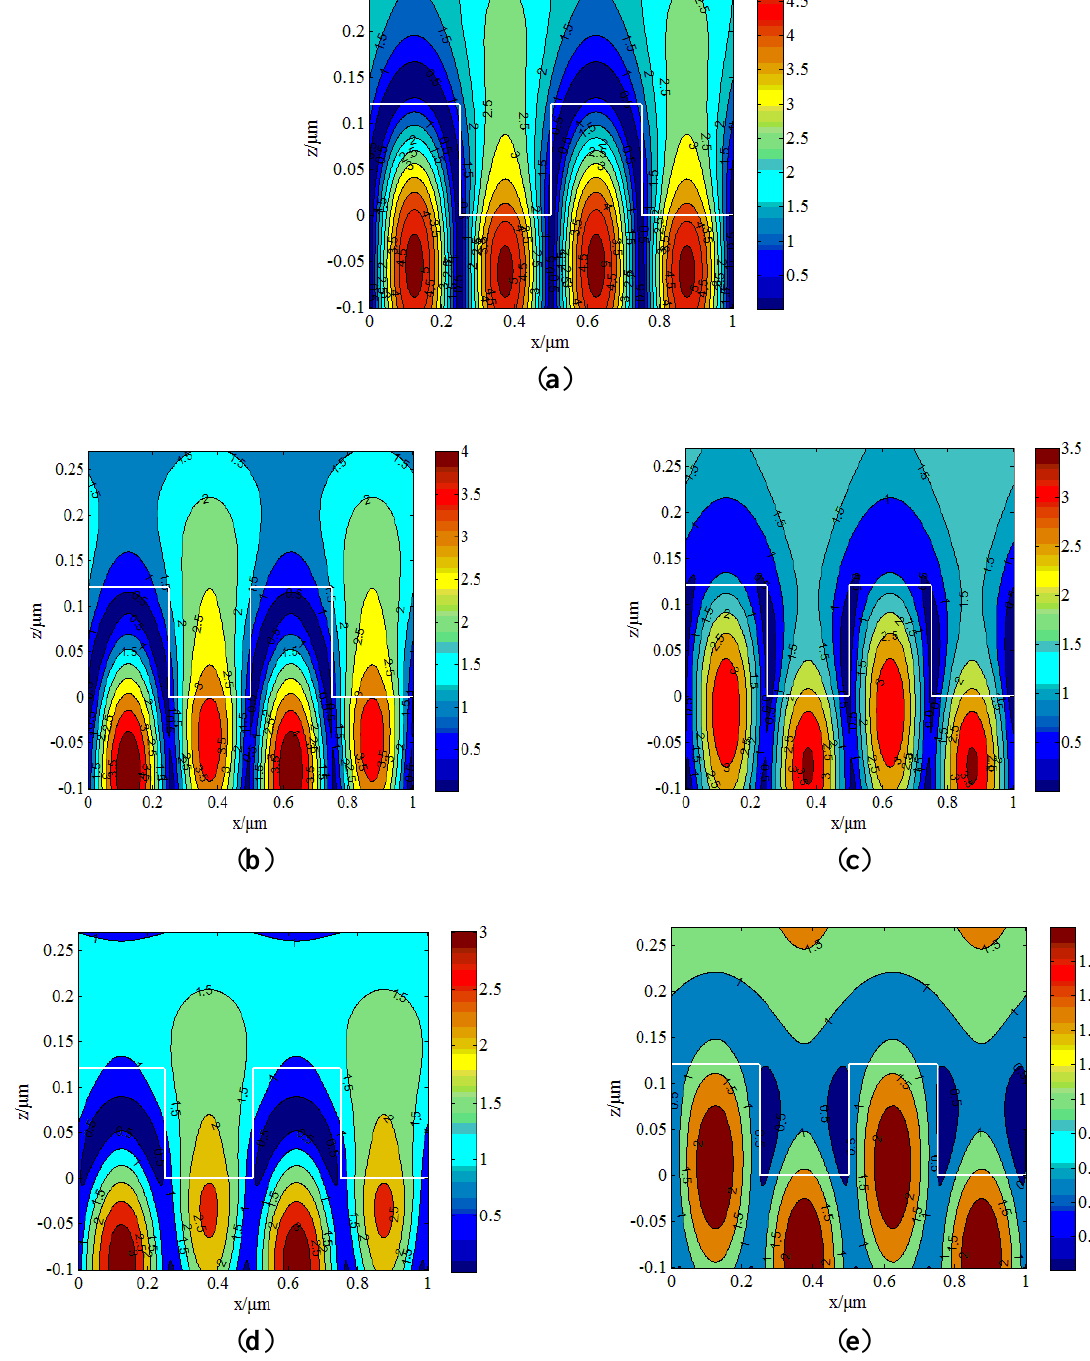
Figure 2. Electric field distribution of TE mode at different wavelengths. ( a ) Electric field distribution at the wavelength of 798 nm with TE mode incident into the GMRF. ( b ) Wavelength at 788 nm. ( c ) Wavelength at 808 nm. ( d ) Wavelength at 778 nm. ( e ) Wavelength at 818